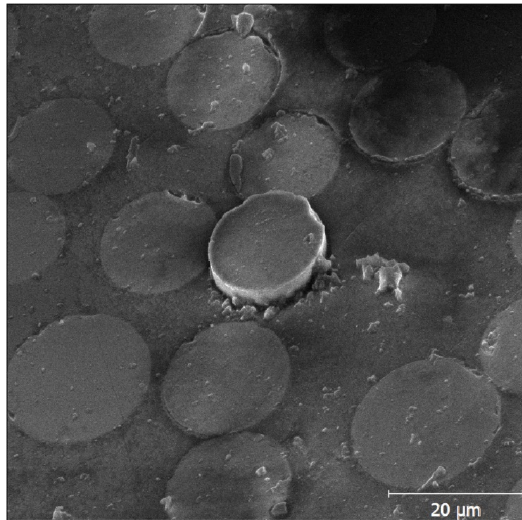
Figure 5. SEM image of the pushed-out fibre.